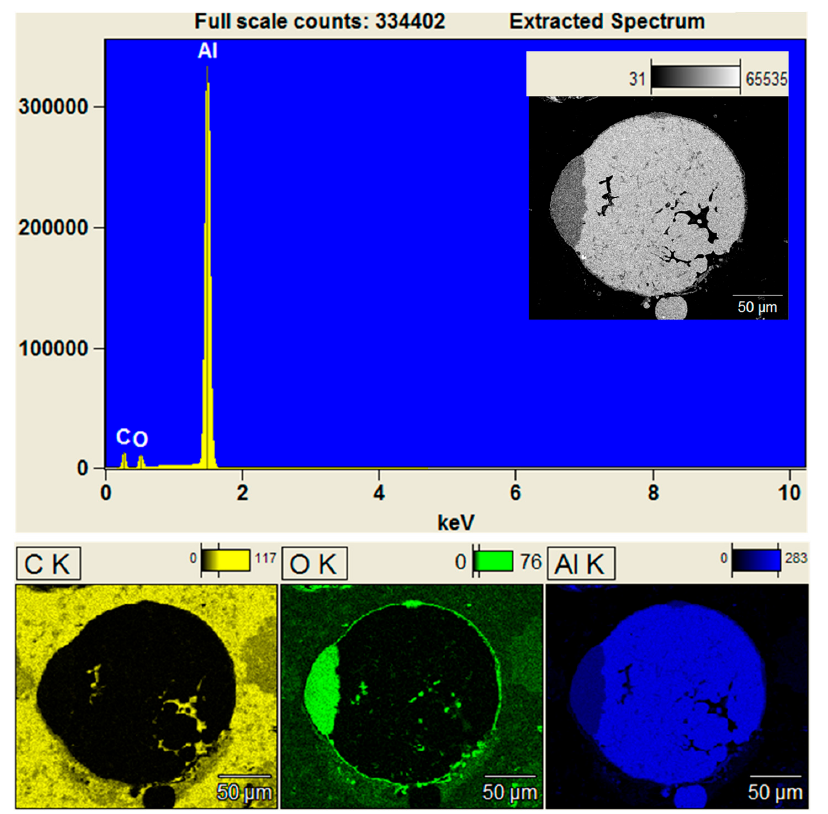
Figure 15. Demonstration of SEM/EDS data to illustrate oxide cap and surface oxidation on alu- minum particle.